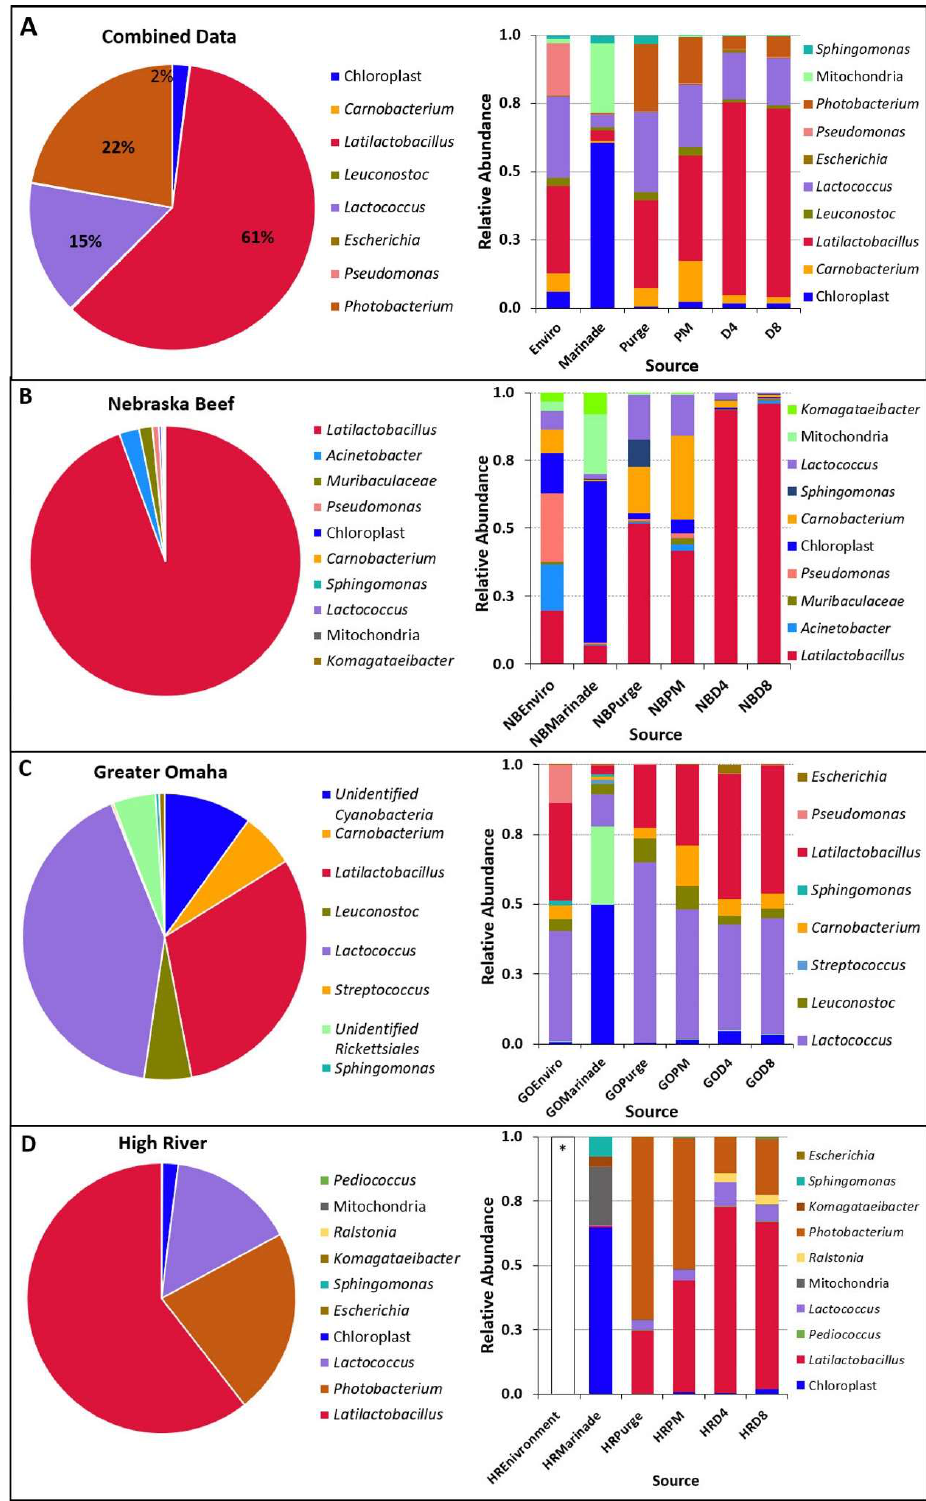
Figure 6. Relative abundance of total identified DNA from across all processing time points and the relation of OTUs to specific sampling sites for ( A ) combined sources, ( B ) Nebraska Beef, ( C ) Greater Omaha and ( D ) High River-JBS. OTUs were based on abundance, including non-bacterial data (mitochondria and chloroplast). Relative abundance of organisms among specific process sampling points included Enviro/environmental samples; PM, post-marinade beef; D4, beef dried four days; D8, beef dried eight days. * Insufficient DNA was recovered for subsequent